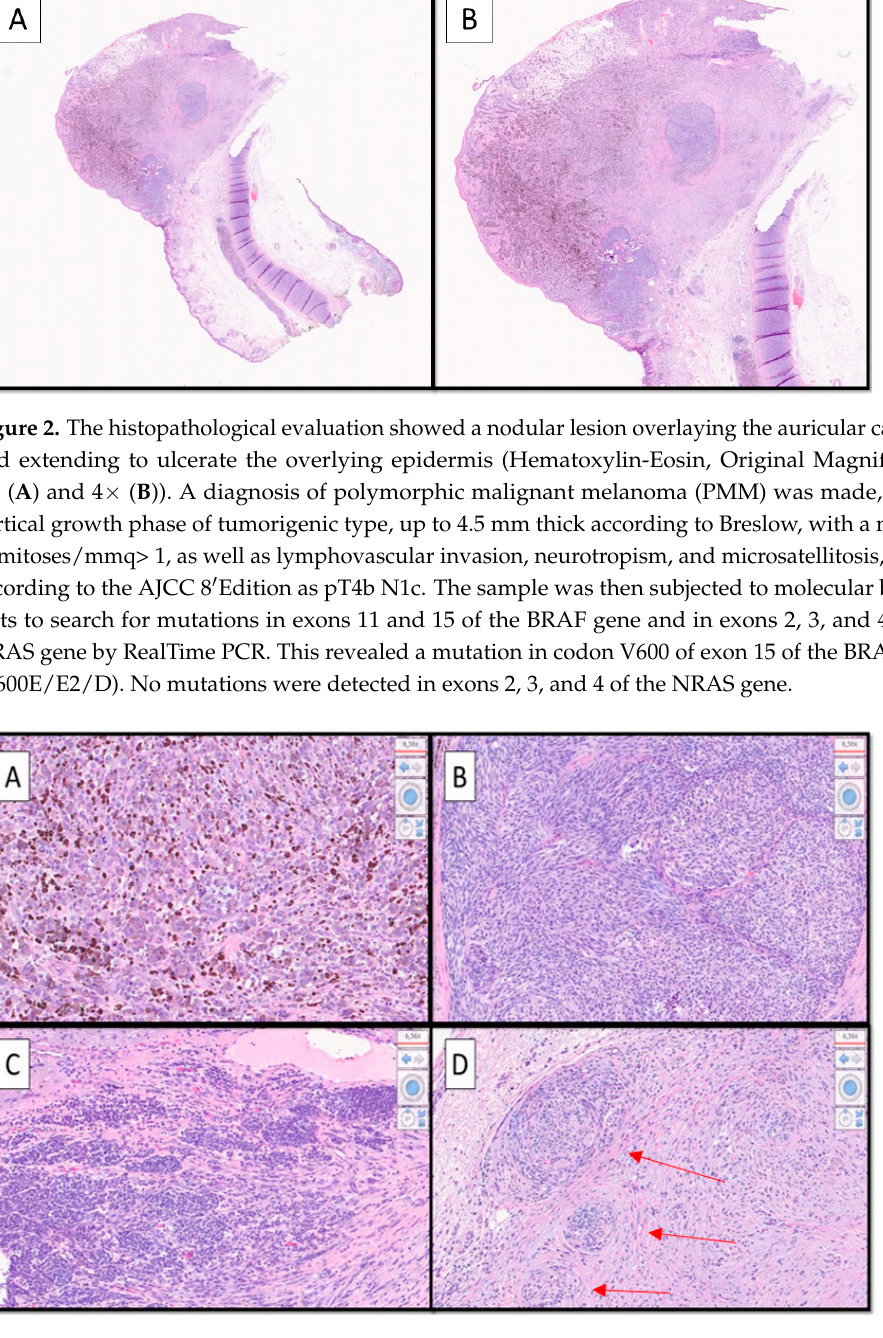
Figure 3. ( A – D ). At higher magnification, a heterogeneous morphological pattern was evident, consisting of different aspects; alongside the superficial spreading type (SSM) melanoma component (not shown) there were hyperpigmented epithelioid cell aspects ( A ), hypopigmented spitzoid features ( B ), nevoid aspects that tended to lose HMB-45 immuno-expression ( C ), and aspects of desmoplastic / neurotropic melanoma ( D ). Furthermore, a rhabdoid appearance could be appreciated (not shown). Note in ( D ) neurotropism of malignant melanoma cells (red arrows). (Hematoxylin-Eosin, Original Magnification 20×). Indeed, it has been decided to have the patient undergo sentinel lymph node surgery (BLS) and then, based on the result, a decision will be made for possible medical therapy. It is very important to recognize the different morphological forms of MM, as it is recognized in the literature to what varying extents this neoplasm is able to be “plastic”. For example, in a recent paper, Massi D. et al. dealt with the discourse relative to the morphophenotypic and genetic plasticity of MM, analyzing the very rare case of dedifferentiated MM [1]. Figure 4. ( A – D ). ( A ) Immunohistochemical preparation with anti-Human Melanoma Black Antigen-45 (HMB-45) antibody showing strongly positive epithelioid cell features. ( B )